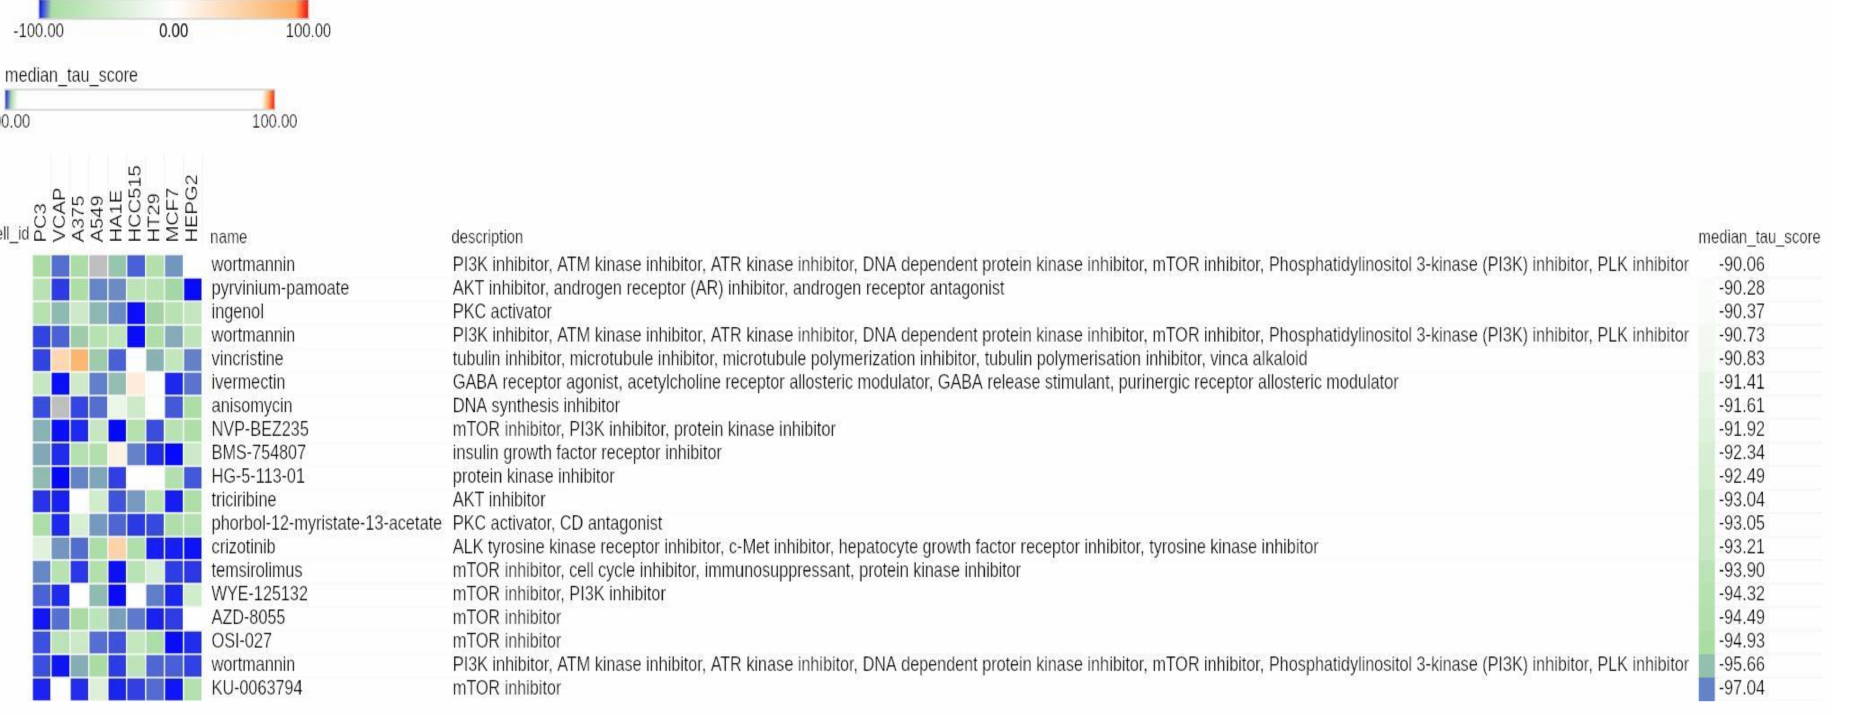
Figure 1. Connectivity Map (CMap) results displaying significant connections between compounds and hypoxia-modulated genes in neuroblastoma (NB). Heat map showing the connectivity score between each cell line (columns) and the most significant compounds (rows). The heat map was generated using the CMap tool. Numeric identifier, compound name, description, and median tau score for each compound are indicated. The cell line identifier is shown on top. The median tau score measures the strength of connection between a query signature and a drug across multiple cell types. Compounds are considered significantly connected with the reference signature when the mean tau score is lower than − 90. Compounds are sorted by decreasing order of median tau score. Color keys are displayed on top of the